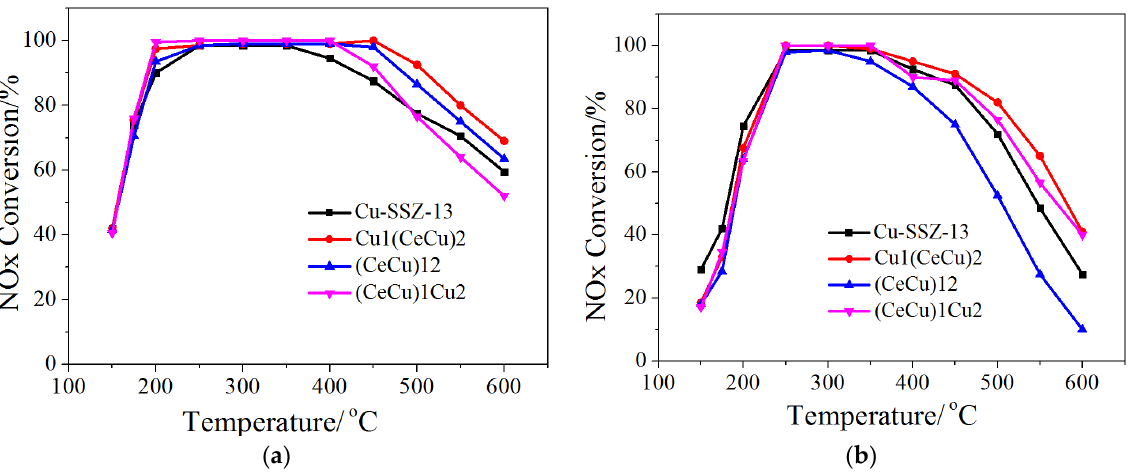
Figure 1. NH 3 ‐ SCR performance of fresh ( a ) and aged ( b ) Cu ‐ SSZ ‐ 13 and Ce ‐ modified Cu ‐ SSZ ‐ 13 catalysts. Figure 1. NH 3 -SCR performance of fresh ( a ) and aged ( b ) Cu-SSZ-13 and Ce-modified Cu-SSZ-13 catalysts.